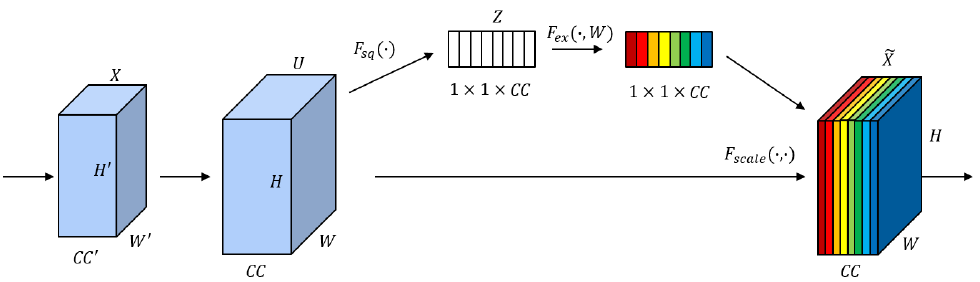
Figure 2. The structure map of the SE